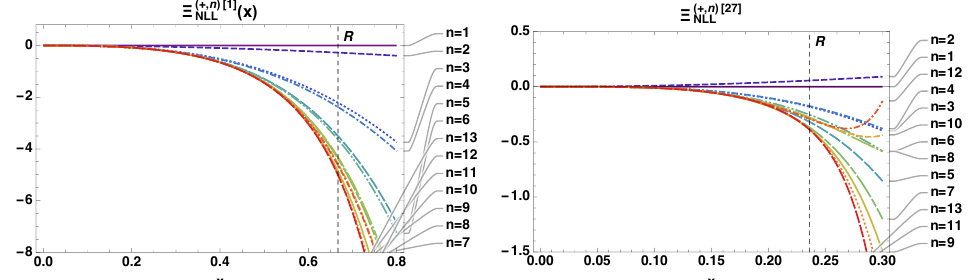
(+ , (cid:96) ) , up to 13th order, for the NLL